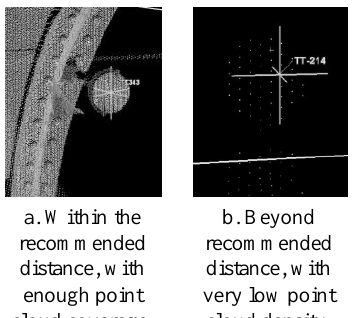
Figure 2. Different types of targets